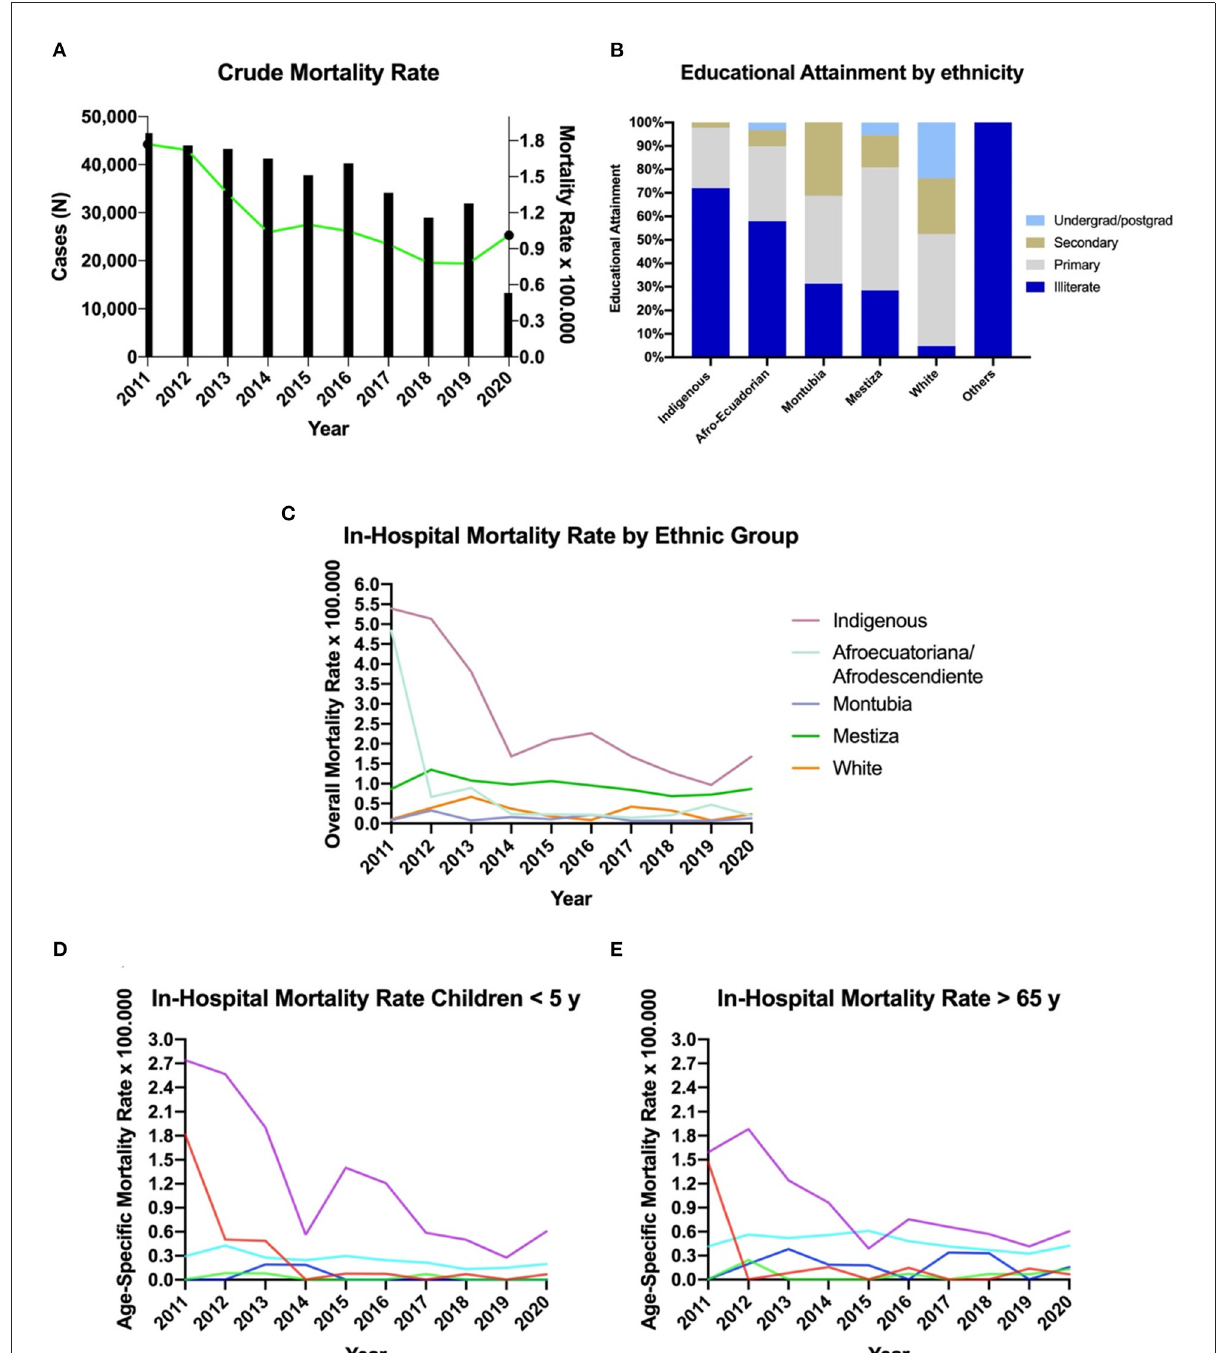
FIGURE2 Mortality due to waterborne diseases in Ecuador from 2011 to 2020. (A) Mortality rate due to WBD in Ecuador from 2011 to 2020. (B) Educational attainment by ethnic group in Ecuador. (C) Overall mortality rate by ethnic group. (D) Mortality rate by ethnic group in among children younger than 5 years of age. (E) Mortality rate by ethnic group in people older than 65 years of